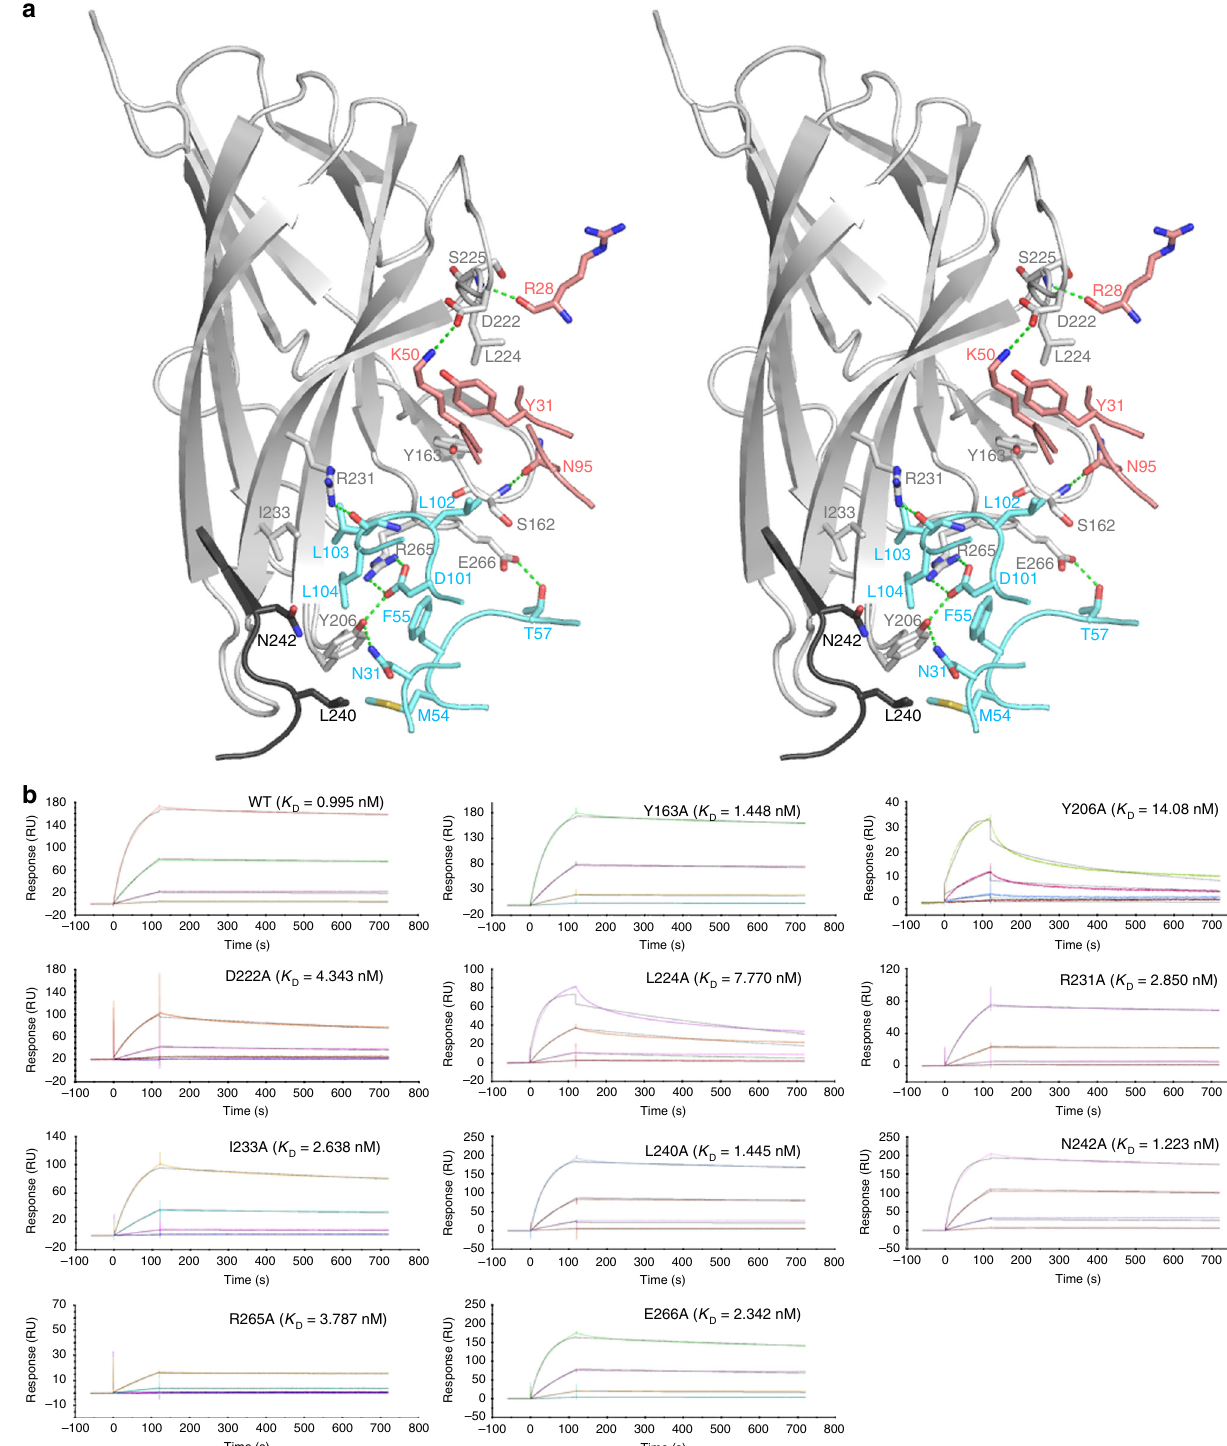
Fig. 4 The BAFF – belimumab Fab interface. a Stereoview of the detailed BAFF – belimumab Fab interface. The carbon atoms from two neighboring BAFF protomers and the heavy and light chains of belimumab are colored gray, black, cyan, and pale red, respectively. Hydrogen bonds and salt bridges are indicated with dashed lines. b SPR sensorgrams for the binding kinetics of BAFF wild-type and mutants to the belimumab Fab. The concentrations of the wild-type and mutant BAFF for each experiment are 2, 10, 50, and 250 nM. For each experiment, one sensorgram out of two independent measurements with nearly identical results is